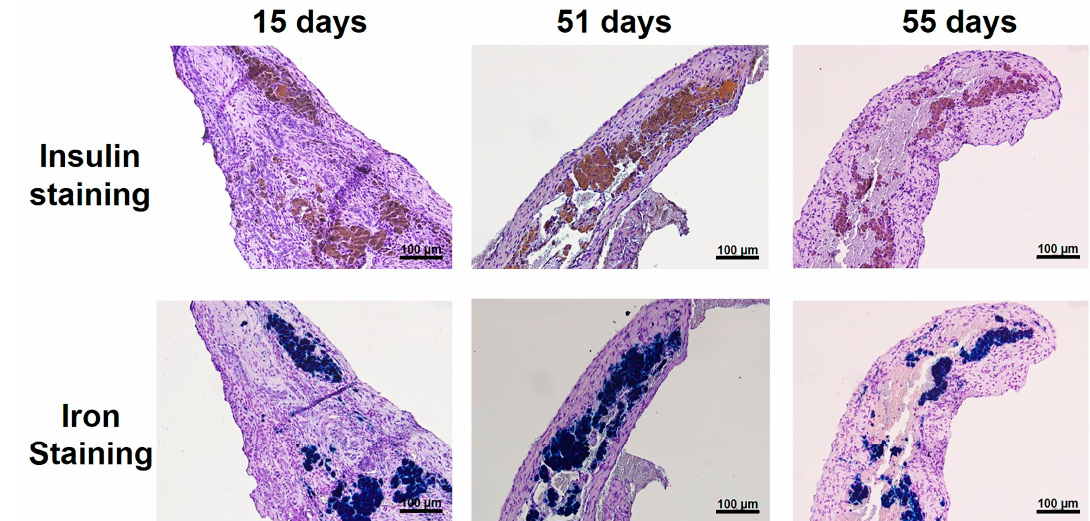
Figure 5. NPCC grafts at 15, 51, and 55 days after transplantation. The graft was stained with insulin (upper panel, brown color) and Prussian blue (lower panel, blue color), which were colocalized.